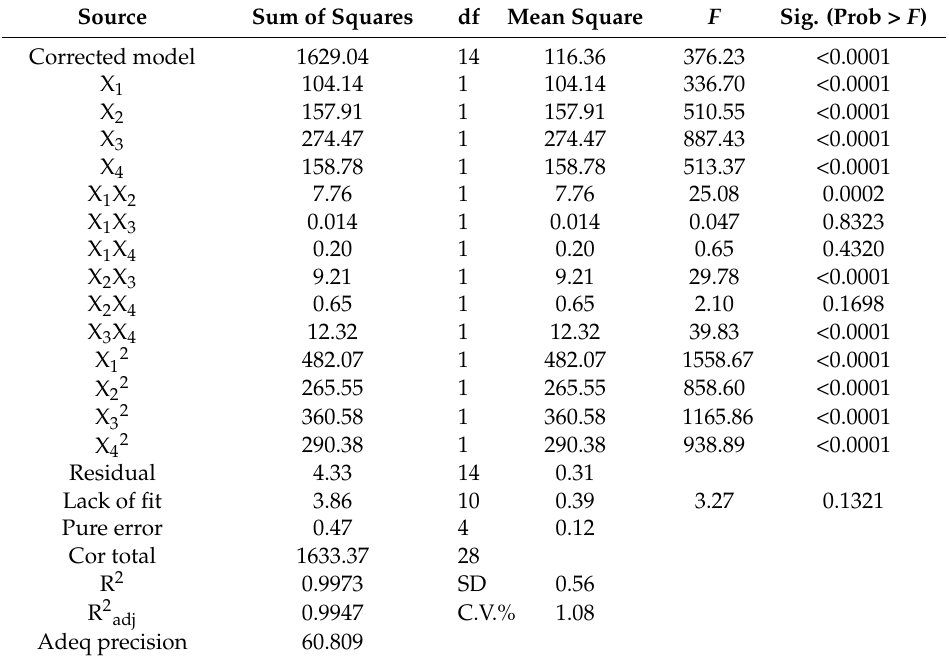
Table 3. ANOVA for the dependent variable: the DPPH scavenging percentage of RAMP. Source Sum of Squares df Mean